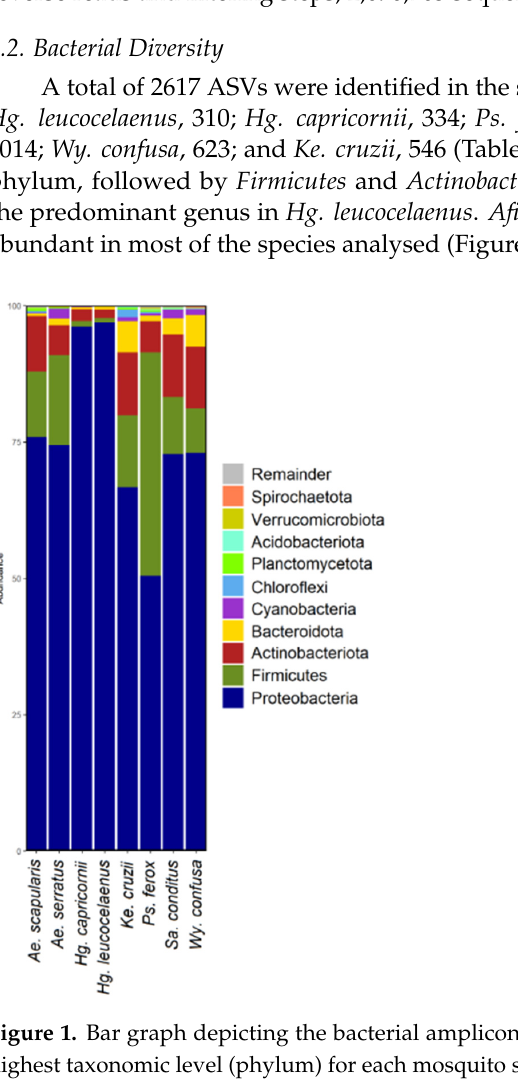
Figure 2. Bar graph depicting the bacterial amplicon sequence variants (ASV) composition at the bottom taxonomic level (genus) for each mosquito species. Remainder (gray bars) corresponds to genera that had 2% or less of the total contigs analyzed.